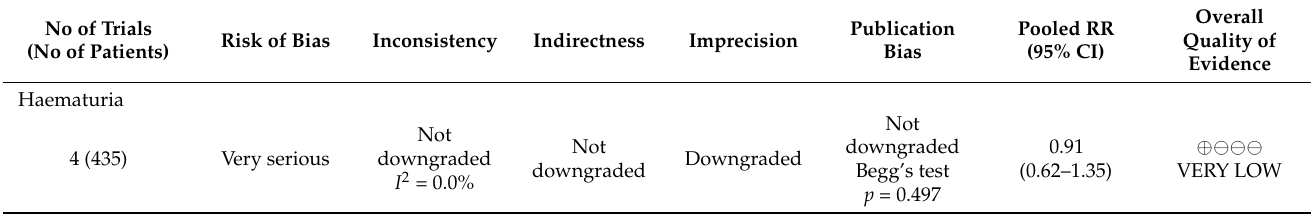
Table 6. Presenting certainty of evidence (CoE) by “Grading of Recommendations Assessment, Development and Evaluation” (GRADE) methodology to assess the quality of evidence with individ- ual